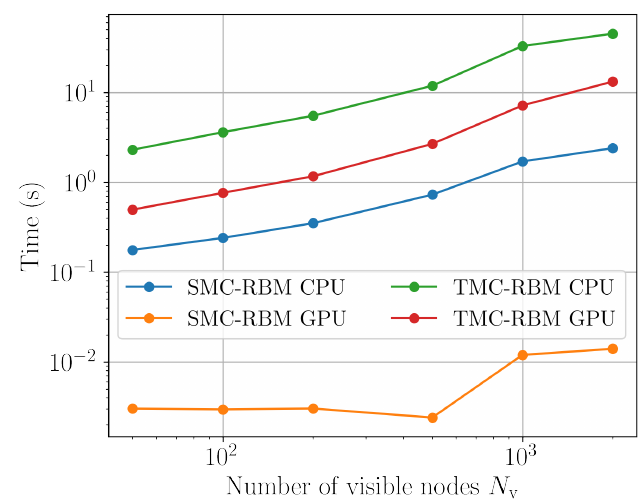
Figure 12: We show the average wall time per epoch (averaged over 20 epochs) for RBMs trained on either CPU / GPU and using the TMC or SMC method during learning. The curves were generated with a Geforce RTX 3090 as GPU and an AMD Ryzen 9 5950X as